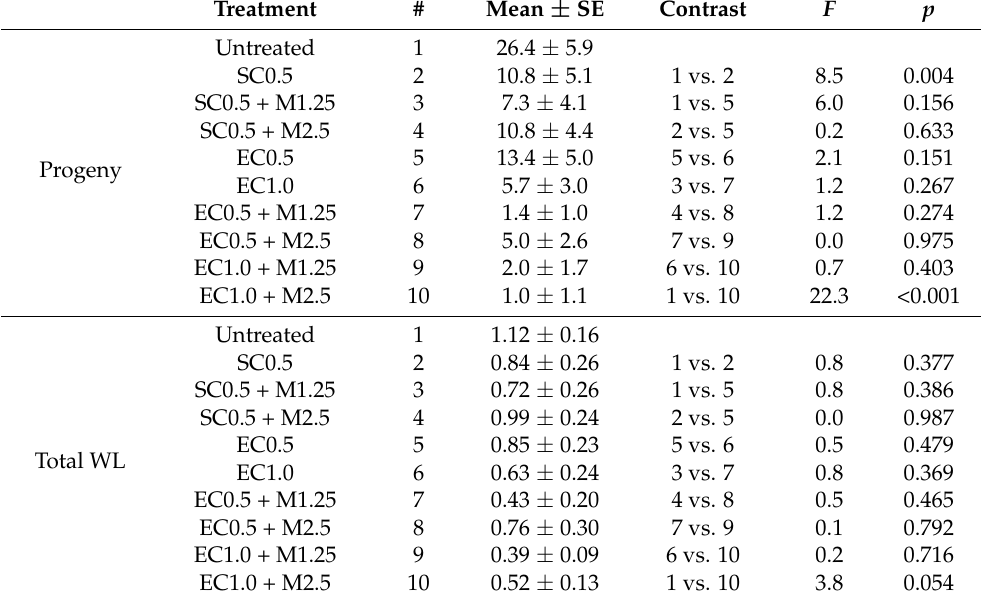
Table 5. Progeny production, total weight loss (WL in %), and feeding damage (Frass wt. in mg) (means ± SE) from exposure of 10 mixed-sex parental adult S. zeamais on untreated corn and corn treated with the insecticide combinations Table 1. F and p values given for selected orthogonal